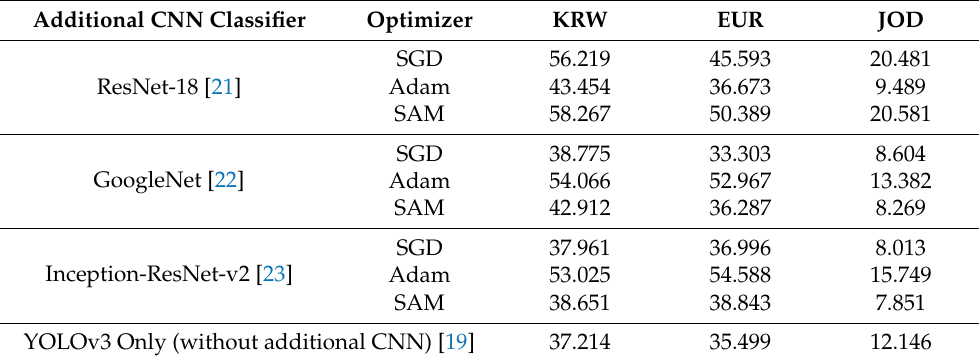
Table 5. Experimental results of training on USD and testing on the other currency types using YOLOv3 and single state-of-the-art CNN classifier. (Measure: mAP, unit: %). Additional CNN